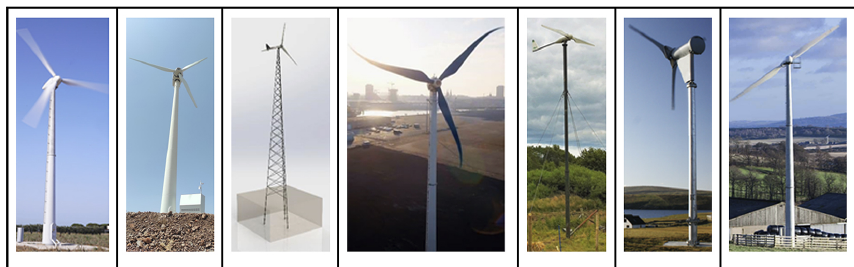
Figure 12. Common HAWT archetypes found on the current DWT market. From left to right: upwind, active pitch and yaw (photo credit: Tozzi Nord); upwind, stall-controlled and active yaw (photo credit: Eunice); upwind, stall-controlled and tailed passive yaw (photo credit: NREL pix 49511); downwind, stall-controlled and passive yaw (photo credit: Eocycle – formerly XANT); upwind, tailed passive yaw, furling (photo credit: Bornay); downwind, pitch- or pitch-coning-controlled, passive yaw (photo credit: SD Wind, formerly Proven); downwind, stall-controlled, passive yaw and teeter (photo credit: Ryse Energy, formerly